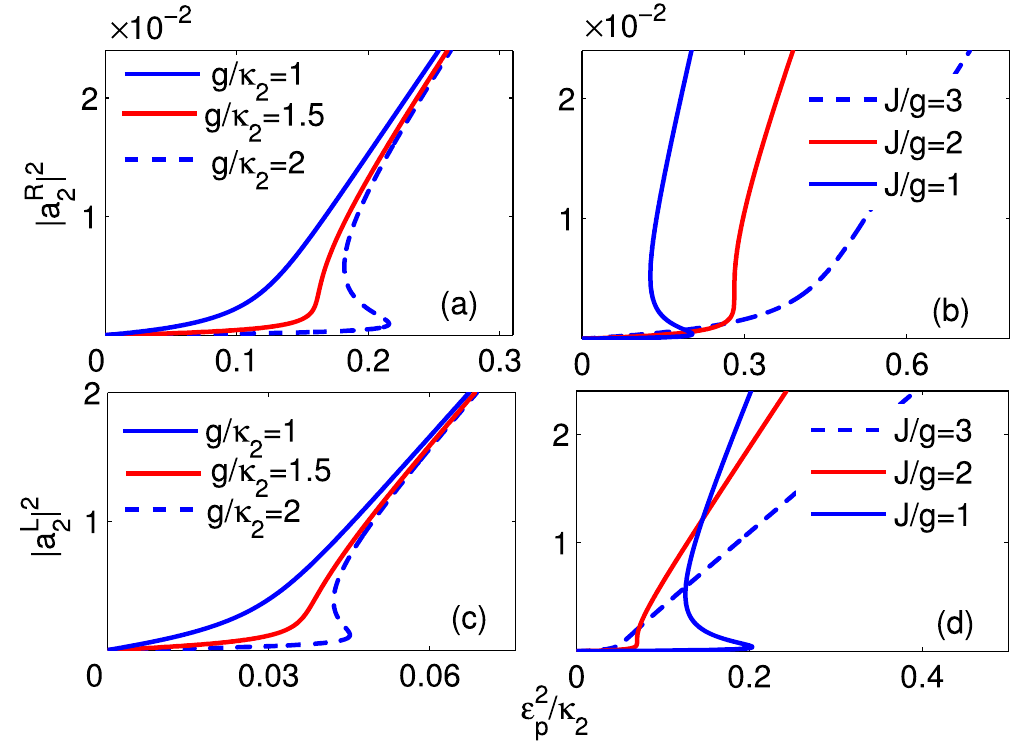
Figure 6. The output field controlled by the coupling strengths. For the passive-passive case, the output field 2 2 as a function of the input field ε κ / a a , R L 2 1 parameters are chosen as γ = 0.1